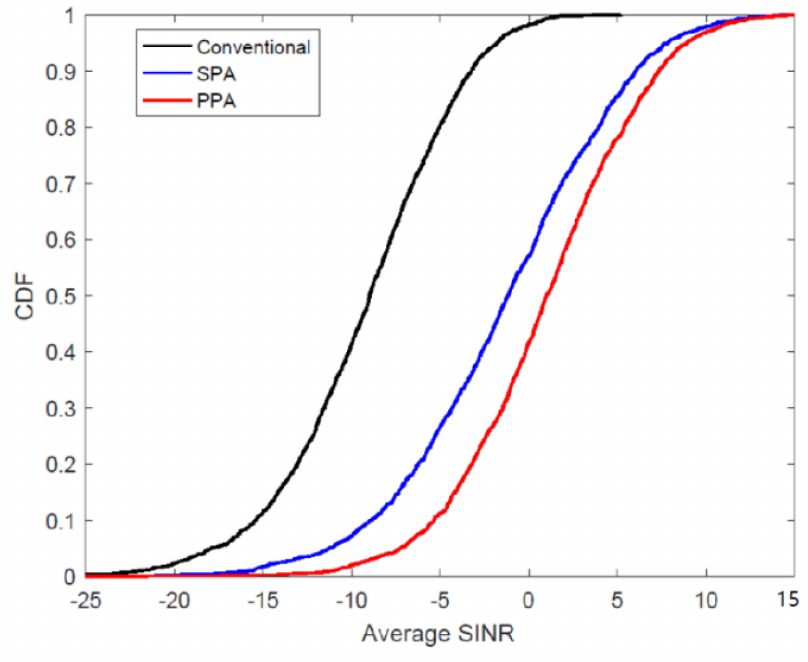
Figure 4. Cumulative distribution function (CDF) of the average signal-to-interference-plus-noise ratio (SINR) per user when M = 64 using a ZF detector.